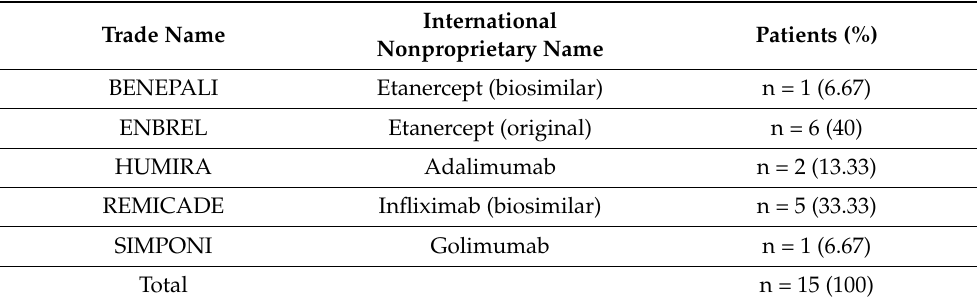
Table 6. Distribution of AS patients with positive QFT test results depending on the biological